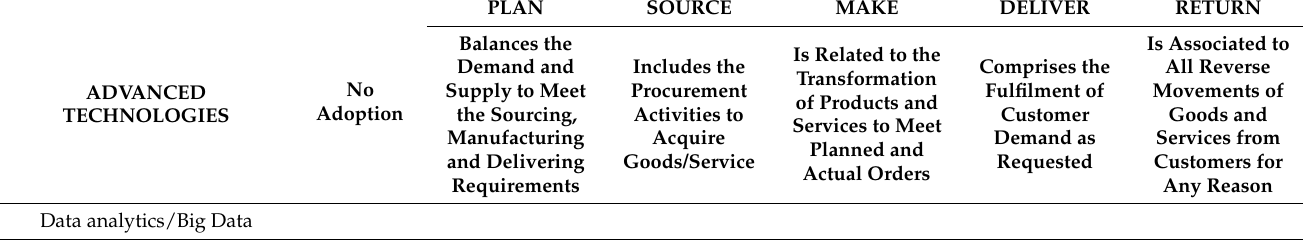
Table A1. SCOR Processes where the Advanced Technologies Are